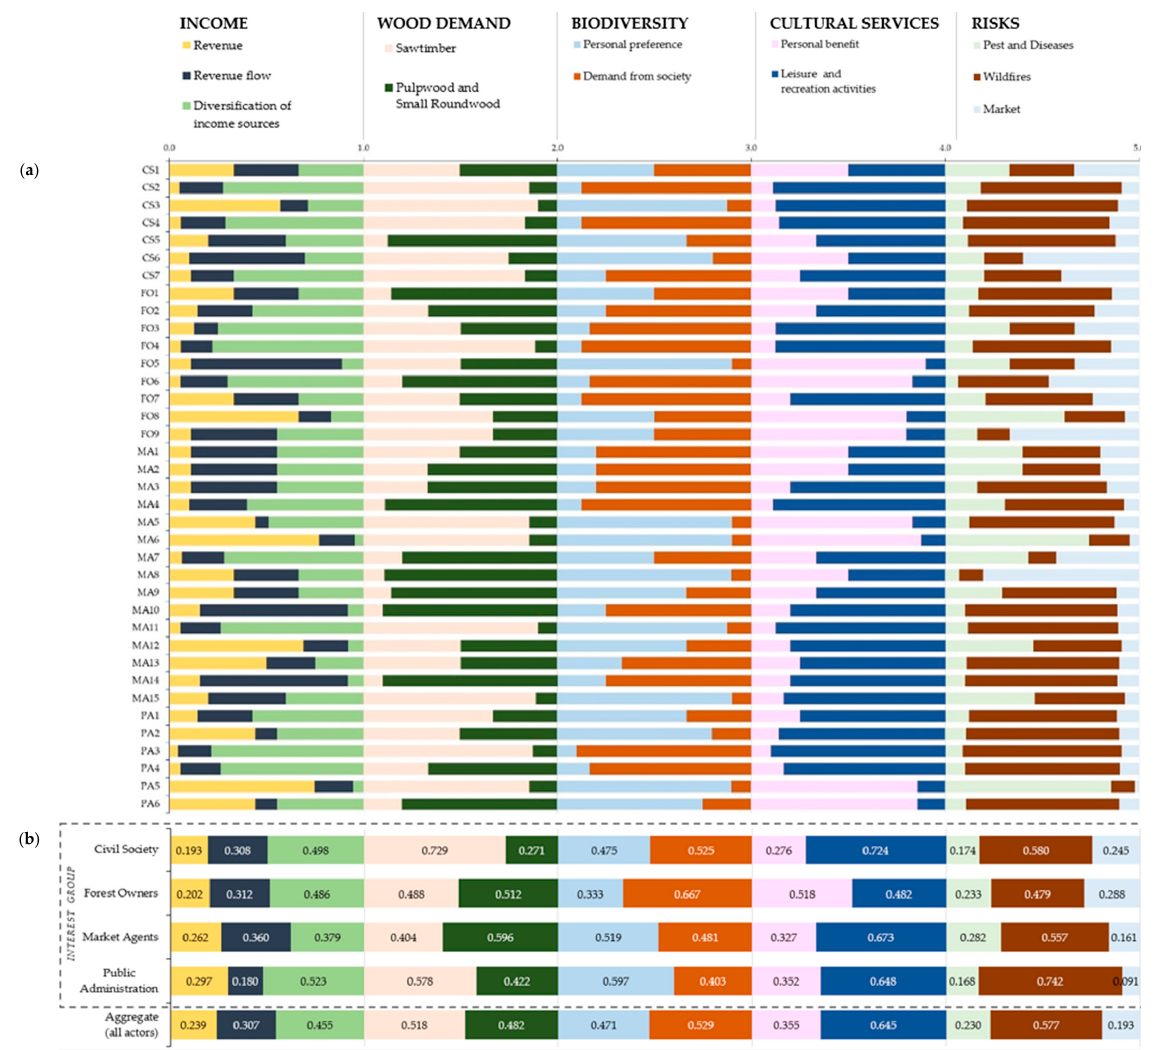
Figure 9. Weights of sub-criteria: ( a ) Weights assigned by each actor (CS—civil society; FO—forest owners; MA—market agents; PA—public administration)—absolute weights for each sub-criterion can be computed as the product of the relative weight shown here and the associated criterion weight from Figure 8; ( b ) Aggregated weights by interest group and aggregated all actors. Sub-criteria weights for each interest group were calculated with the consensus convergence algorithm which is presented in the Code A1 and the aggregate weights of all actors’ sub-criteria were calculated with Equation (1).